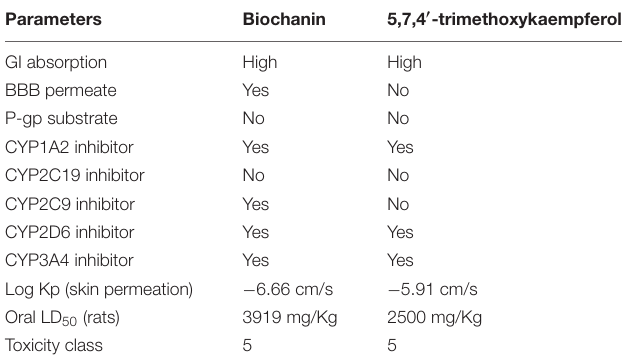
TABLE 2 | Predicted toxicity and drug likeness of isolated